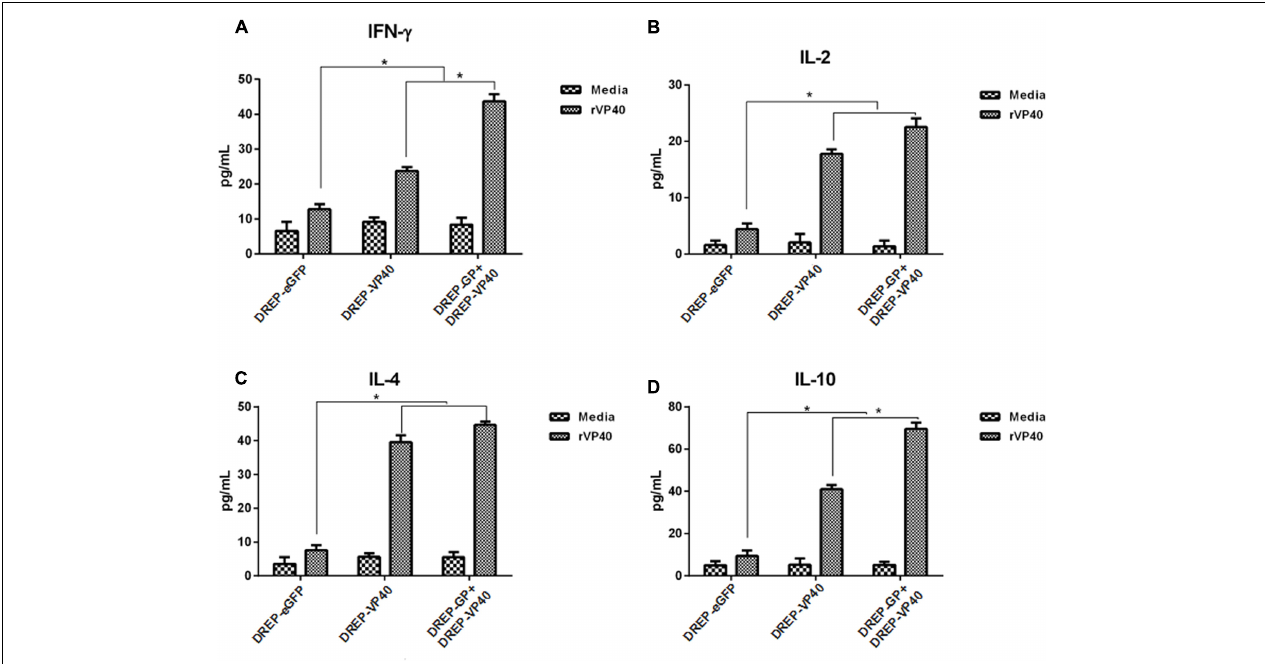
FIGURE 5 | ELISA analysis of cytokines secreted by splenocytes from immunized mice upon stimulation with EBOV recombinant VP40 proteins (rVP40). (A–D) Determination of the cytokines IFN- γ (A) , IL-2 (B) , IL-4 (C) , and IL-10 (D) production in the supernatant of splenocytes by ELISA 2 weeks after the final immunization. The results for three independent experiments are shown as the mean ± SD. ∗ p <